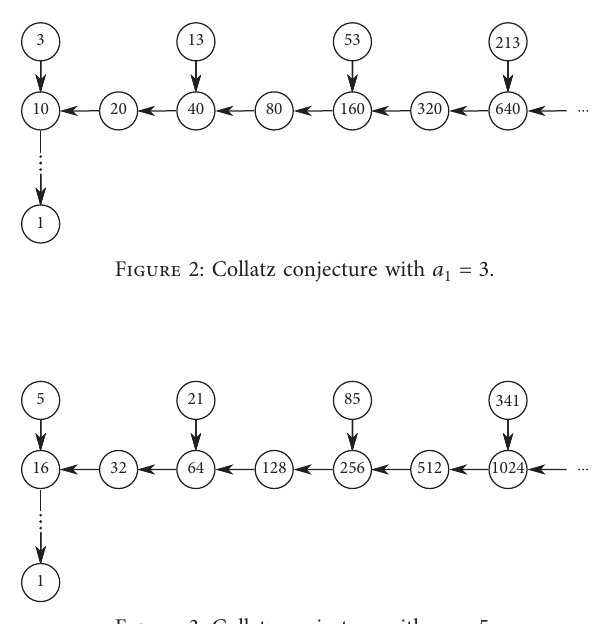
Figure 3: Collatz conjecture with a